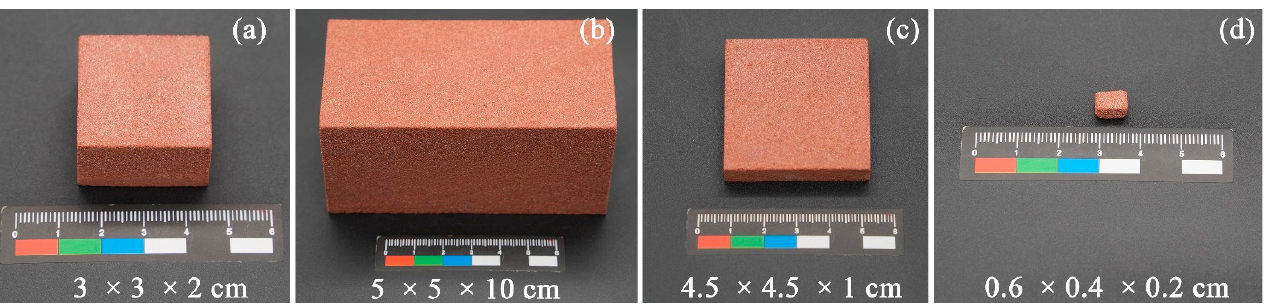
Figure 1. Stone samples used for the tests: ( a ) contact angle, color, thermal ageing, UVA ageing, chemical stability; ( b ) water absorption by capillarity; ( c ) water vapor permeability; ( d ) SEM.